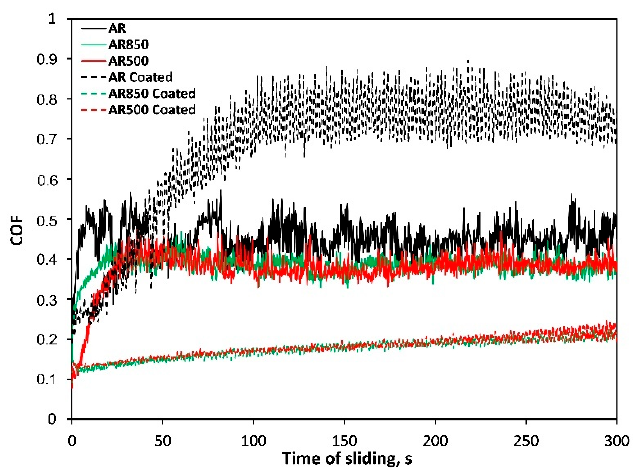
Figure 8. Representative friction curves of bare and coated samples in un-lubricated sliding against ball coated with Cr.